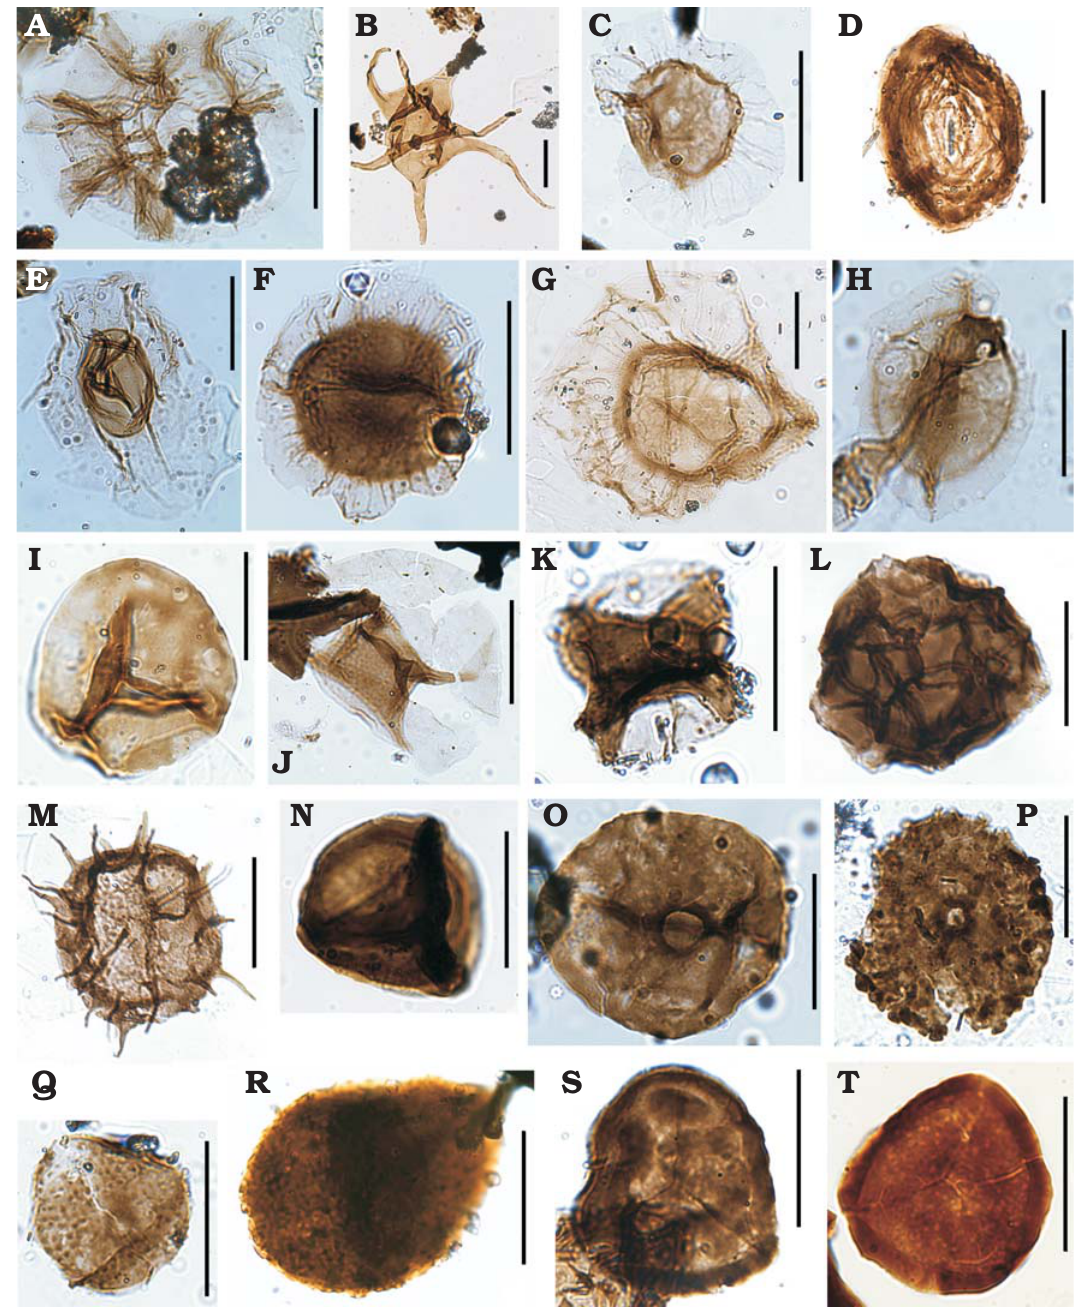
Fig. 10. Palynomorphs from the studied sections of the Los Espejos Formation of Argentina, Cerro La Chilca, Ludfordian (A, E, G, N), Quebrada Ancha, Ludfordian (B, C, F, H, J, K, M, P, R), Quebrada Ancha, P ř ídolí (D, O, Q, S), Cerro La Chilca, Homerian? (I), Quebrada Ancha, Gorstian?–Ludfordian? (L), Cerro La Chilca, Gorstian?–Ludfordian? (T). A . Polyedryxium wenlockium (Dorning, 1981) Le Hérissé, 1989; MPLP 4-61059 (G33). B . Polygonium sp . ; MPLP 7-60736 (E30/1). C . Pterospermella bernardinae (Cramer, 1964a) Eisenack, Cramer, and Díez, 1973; MPLP 7-60736 (F28/4). D . cf. Pterospermella circumstriata (Jardiné, Combaz, Magloire, Penguel, and Vachey, 1972) Eisenack, Cramer, and Díez, 1973; MPLP 9-60664 (U47). E . Pterospermella